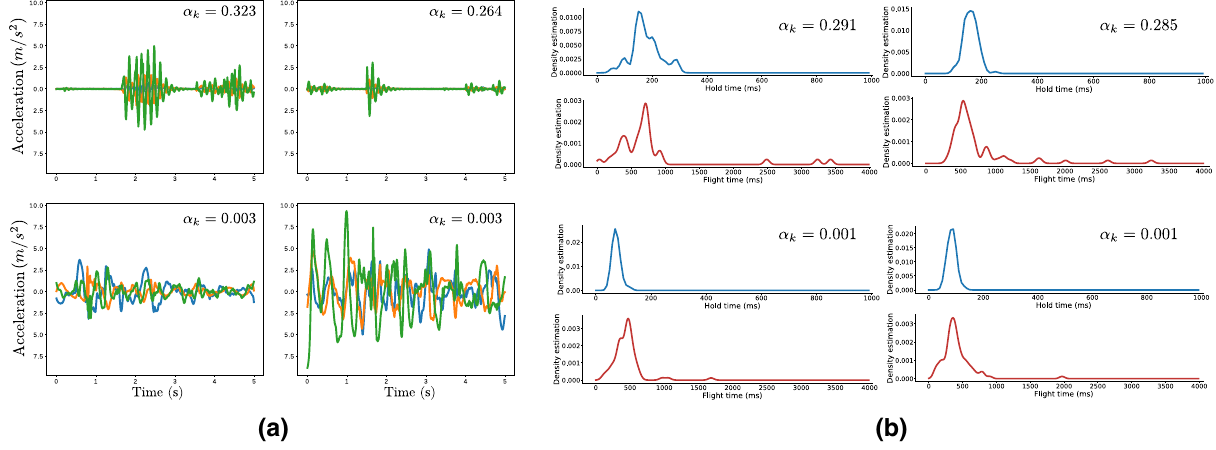
Figure 3. Visualization of bag instances that receive the highest and lowest attention weights by the proposed model. Figures were drawn using Inkscape v1.0 https ://inksc ape.org/. ( a) View of the tri-axial (x-axis: blue, y-axis:orange, z-axis: green) accelerometer segments corresponding to the two highest (top row) and two lowest (bottom row) attention weights assigned by the model, for a PD subject that exhibits tremor. As we can see, the model assigns larger attention weights ak to the acceleration segments that contain sinusoidal components in the PD tremor frequency band of 3–8Hz (top row) and low weights to segments that lack such patterns (bottom left) or whose frequency content is outside the target frequency band (bottom right). ( b ) View of the hold and flight time histograms (smoothed for visualization purposes via a kernel-density estimator) corresponding to the two highest (top row) and two lowest (bottom row) attention weights for a PD subject that exhibits FMI. Notice how the model assigns large attention weights to typing sessions in which the hold and flight time distributions